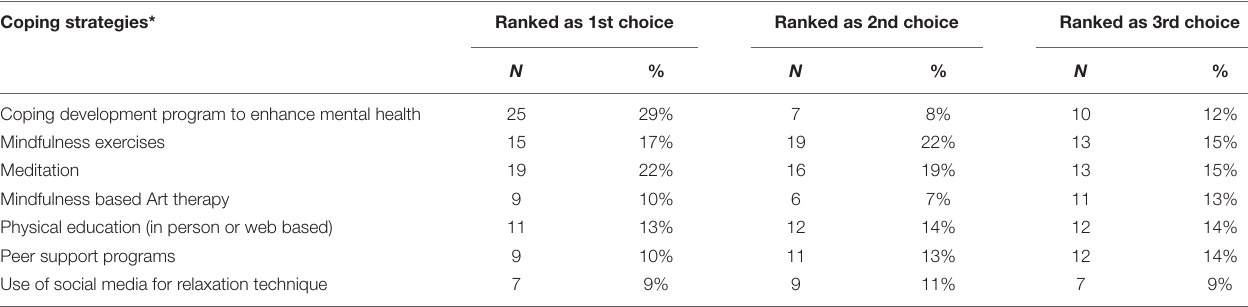
TABLE 2 | Ranking of coping strategies for mental health by college students. Coping strategies*